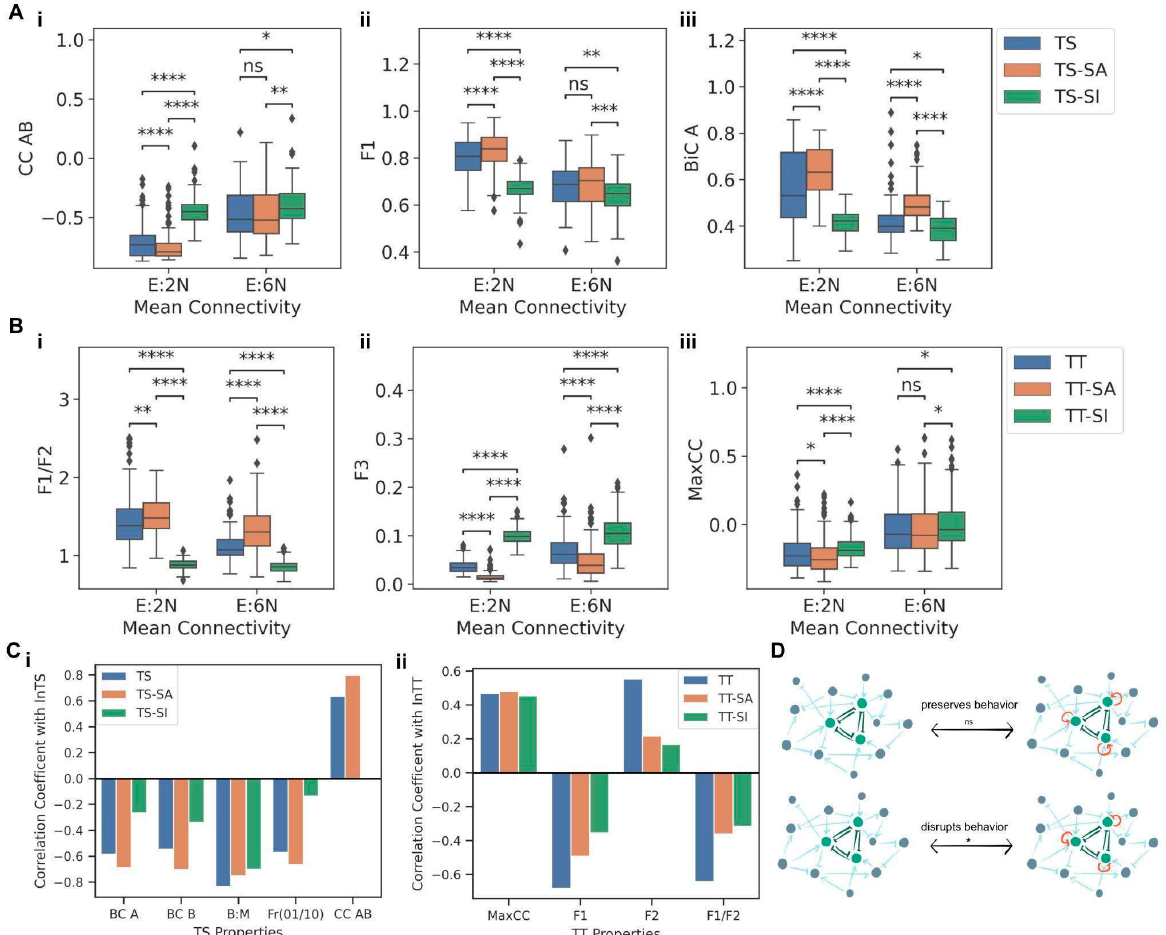
Figure 7. Effect of self-activating and self-inhibiting loops on modularity of TS and TT motifs. ( A ) Comparison between the distributions of (i) CC AB, (ii) fraction of 01 and 10 steady states, (iii) BiC A for TS, TS-SA and TS-SI when embedded in networks of same mean connectivity. ( B ) Comparison between the distributions of (i) F1/F2, (ii) MaxCC, (iii) F3 for TT, TT-SA and TT-SI when embedded in networks of same mean connectivity. ( C ) Comparison of the correlation coefficients of different properties of regular motifs, motifs with self-activation (SA) and self-inhibition (SI) against their respective in-degrees (i) For TS (ii) For TT. ( D ) Schematic showing the effect of self-activating and self-inhibiting edges on motif nodes when embedded in larger networks. p -values of pairwise Mann-Whitney U tests are denoted by: ns— p <= 1, *—0.01< p <= 0.05, **—0.001 < p <= 0.01, ***—0.0001 < p <= 0.001, ****— p <= 0.0001.